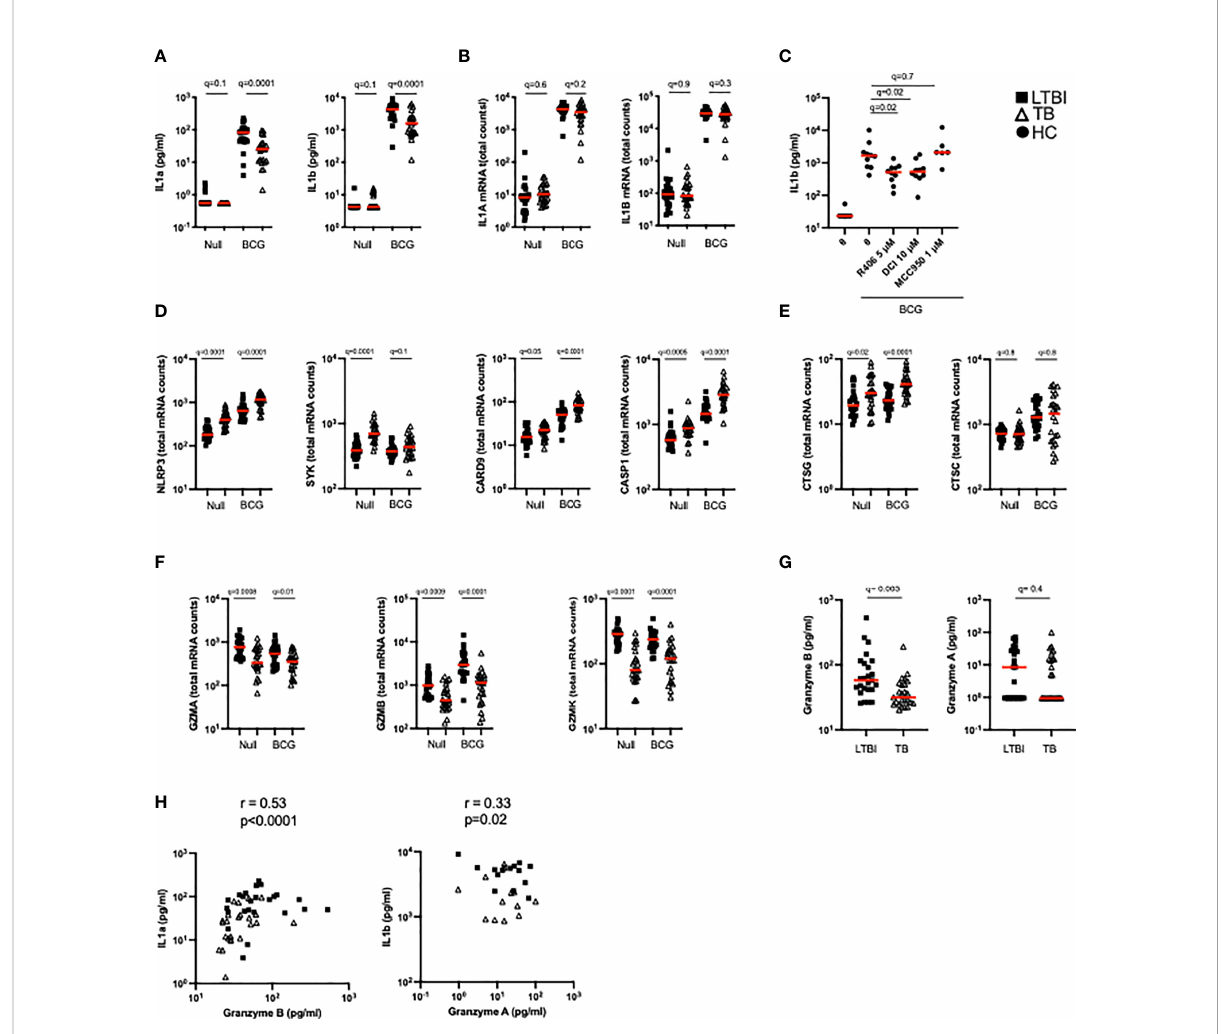
FIGURE 5 TB patients present lower granzyme concentrations which impact levels of functional IL-1 a and IL-1 b . (A) Levels of IL-1 a and IL-1 b protein measured by Luminex in the Null and BCG stimulated conditions. (B) Levels of IL1A and IL1B mRNA measured by Nanostring in the Null and BCG conditions. (C) BCG stimulation of healthy donor blood with the NLRP3 inhibitor MCC950 (1 m M), the Syk inhibitor R406 (5 m M) or the serine-protease inhibitor 3,4-Dichloroisocoumarin (10 m M) (n=7, 2 independent experiments). Levels of mRNA expression for in fl ammasome components NLRP3, SYK, CRAD9 and CASP1 (D) , cathepsins (E) and granzymes (F) measured by Nanostring in the Null and BCG conditions for TB and LTBI. (G) Granzyme A and granzyme B protein concentrations in TruCulture BCG supernatants for TB and LTBI measured by Luminex . (H) Spearman correlation between protein concentrations of granzyme B and IL-1 a , and granzyme A and IL-1 b in BCG supernatants. Paired (C) and unpaired non-parametric t-test corrected for multiple comparisons. Red line: median values. Closed square: LTBI, Open triangle: TB, Closed circle: Healthy Controls. For panels (A – G) , q values (false discovery rate-adjusted p values) are